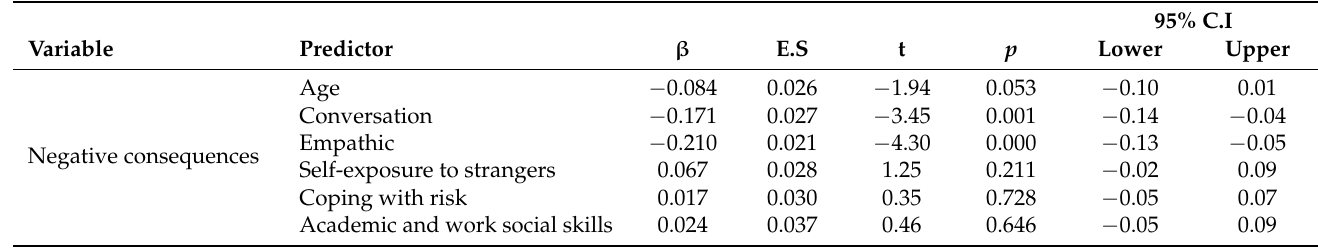
Table 4. Summary of the multiple linear regression model for negative consequences variable in line with the predictor variables included in the analysis.